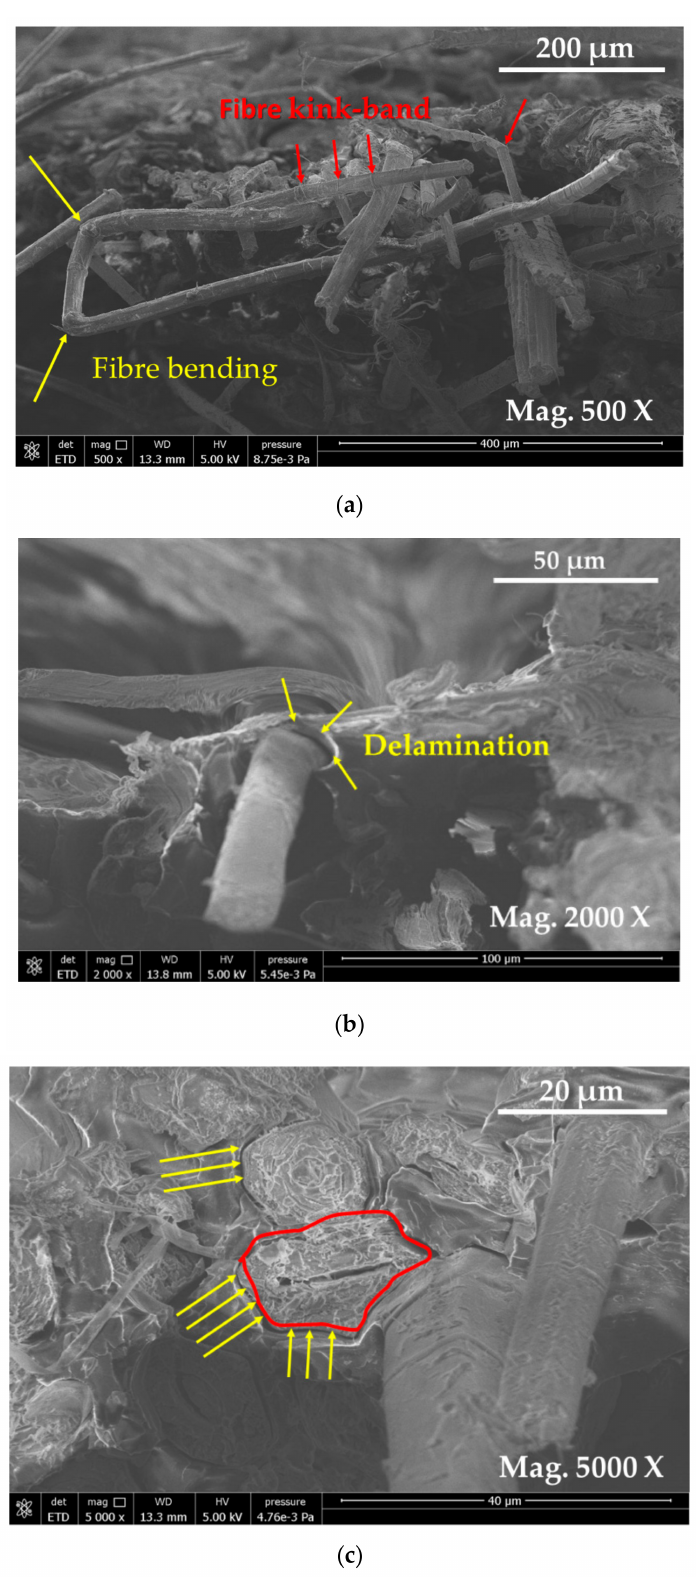
Figure 8. E-SEM micrographs of fractured surfaces of plain flax composites image showing ( a ) magnified view where flax fibres were observed bent in the nodes and flax fibre at the kink-band areas were observed in non-uniform diameter and with some impurities on the surfaces, nodes, and kink-bands observed clearly; ( b ) flax fibres observed delaminated from the matrix; and ( c ) magnified images of flax fibres showing lumen squeezed